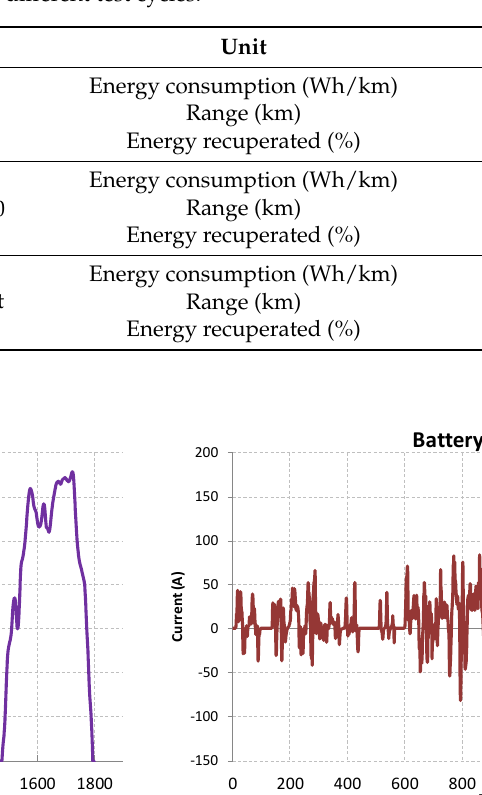
Table 2. Comparison of the energy consumption of electric drive systems in 4 × 2 and 4 × 4 configurations for different test cycles.